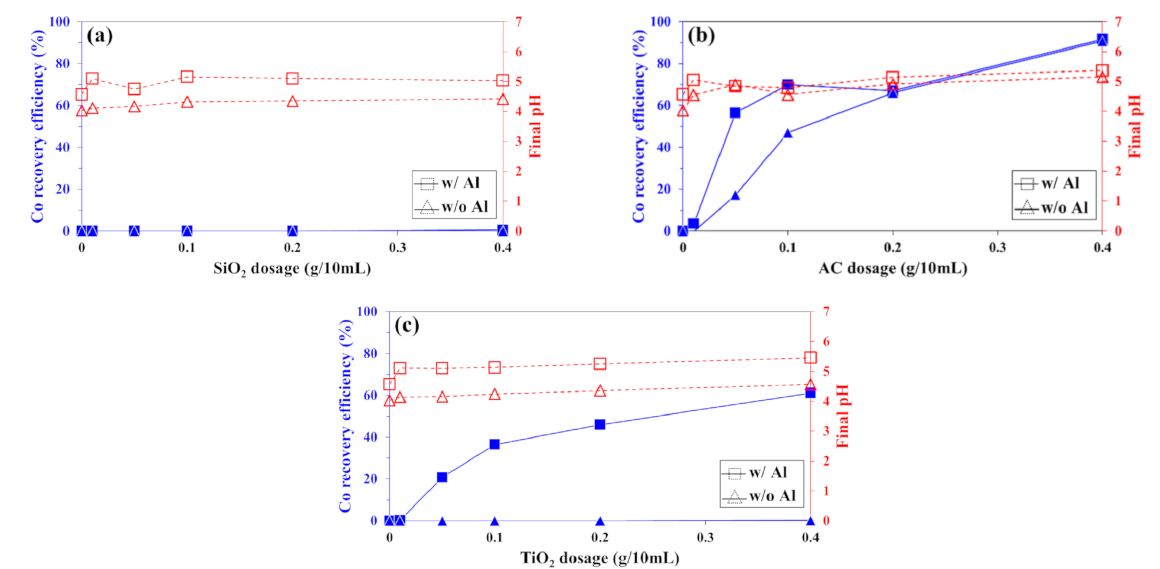
Figure 4. The effects of ( a ) SiO 2 , ( b ) AC, and ( c ) TiO 2 dosages on the recovery efficiency of Co 2+ and final pH in chloride solutions at initial pH 4.0 for 24 h.